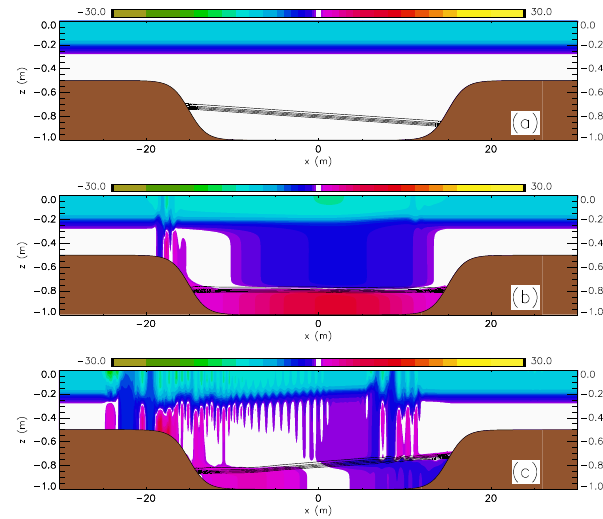
Fig. 14. Contour plots of the density field (solid lines) and hori- zontal velocity field (colours) for the deep seiche. (a) Initial state ( t = 0). (b) t = 60s. (c) t = 120s. The white regions indicate re- gions where | u | < 0 . 0013ms − 1